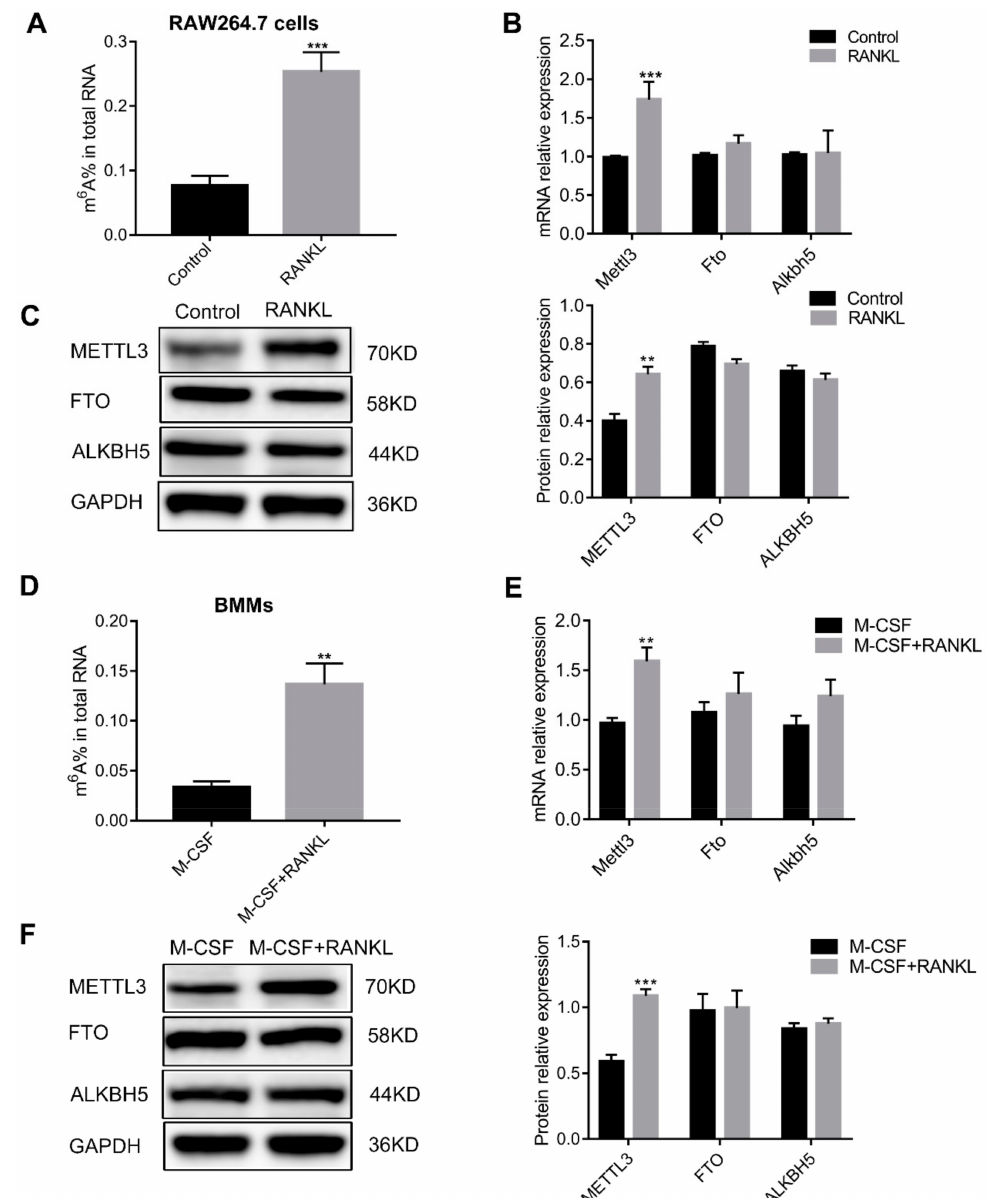
Figure 1. The total m 6 A content and m 6 A modification-related gene expression during osteoclast di ff erentiation. RAW264.7 cells ( A – C ) and bone marrow-derived macrophages (BMMs) ( D – F ) were induced to di ff erentiate into osteoclasts. ( A , D ) The total m 6 A content in cells was measured by quantifying m 6 A RNA methylation. ( B , E ) The mRNA levels of m 6 A modification-related genes were determined by real-time quantitative polymerase chain reaction (qRT-PCR). ( C , F ) The protein levels of m 6 A modification-related enzymes were assessed by Western blotting. Gapdh was used as an internal control. The results represent the mean ± SD ( n = 3). ** P < 0.01; *** P <